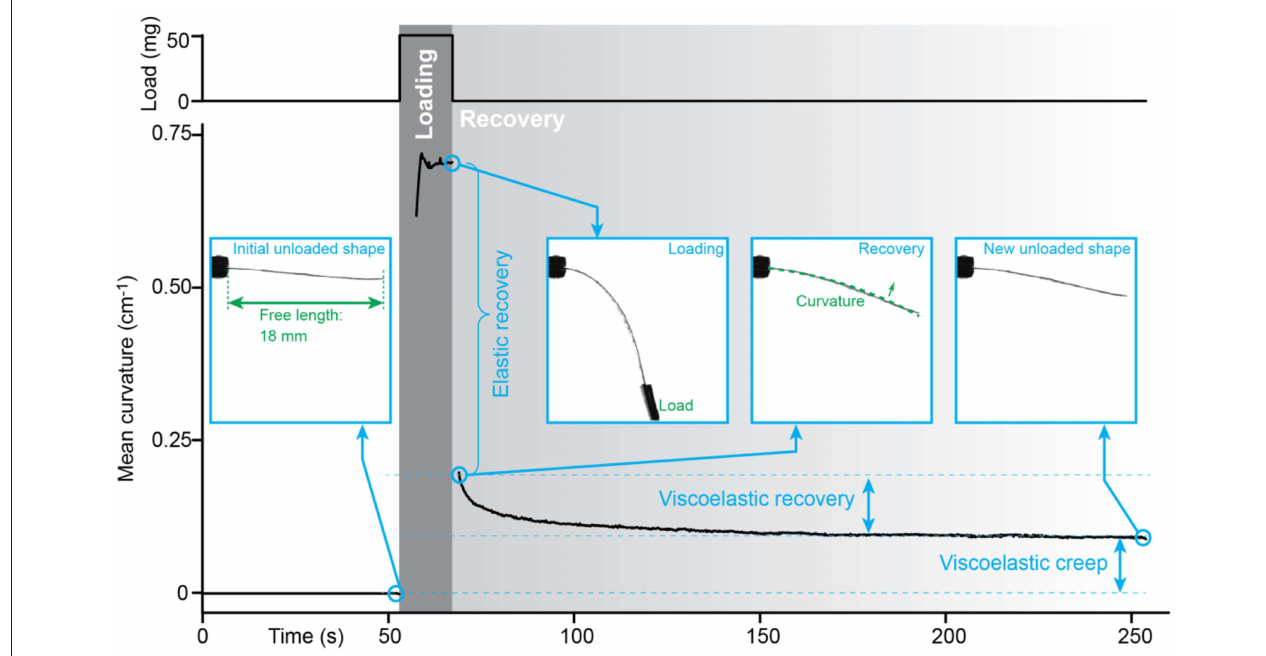
FIGURE 9 | Viscoelastic component in an ICL laminate, evidenced by the inelastic recovery of an ICL